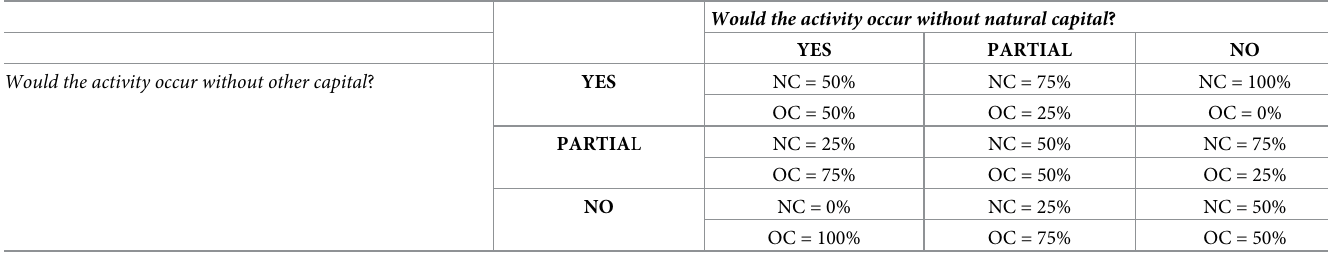
Would the activity occur without natural capital ? YES PARTIAL NO